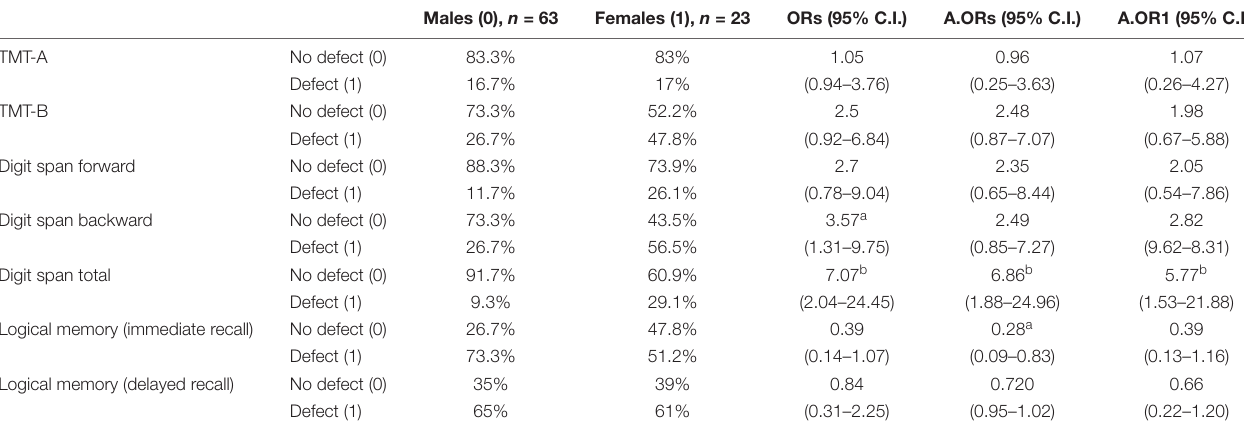
TABLE 3 | Association between gender and neuropsychological results, categorized as with or without defect. Males (0), n = 63 Females (1), n = 23 ORs (95% C.I.) A.ORs (95% C.I.) A.OR1 (95% C.I.)